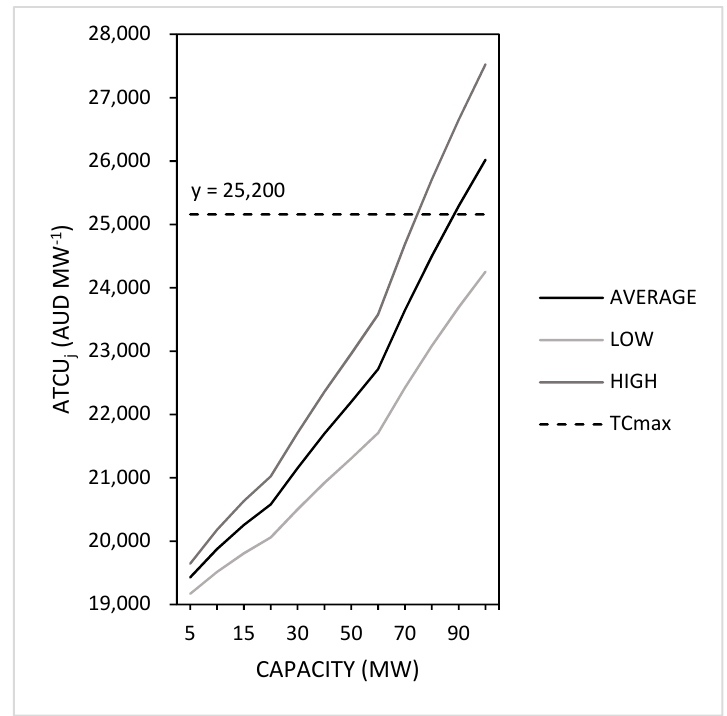
Figure 7. Sensitivity of mean ATCU j of ten best strategic locations to changes in fuel price.